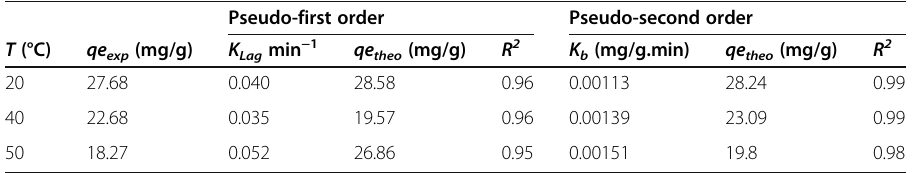
Table 3 Kinetics data the nickel adsorption of by BF